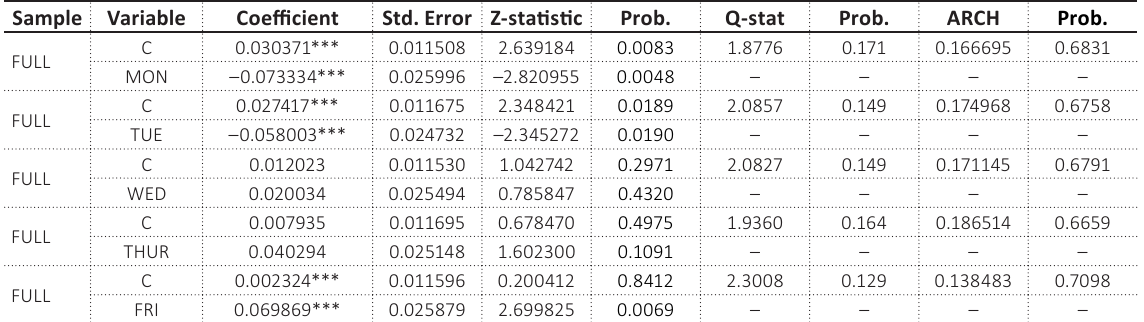
Table 1. Day-of-the-week effect results Sample Variable